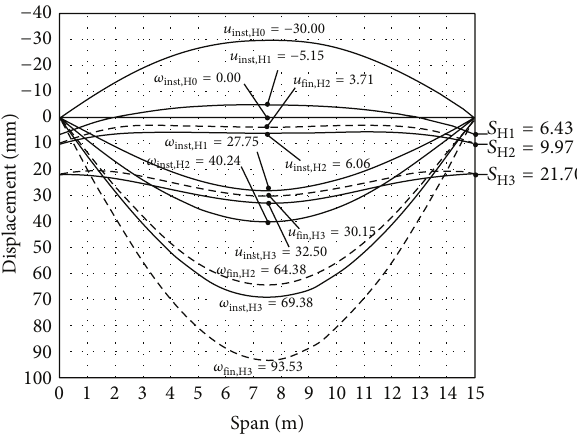
Figure 2: Bending deformations of 𝜋 section pieces with no pres- tressing (S1) and pieces with prestressing and a self-tensioning system (S2). 𝐿 = 15 m; 𝐵 = 600 mm; 𝑏 = 180 mm; 𝐻 = 450 mm; = 360 mm; ℎ = 90 mm; 𝛼 = 26.57 ∘ ℎ 1 2 0